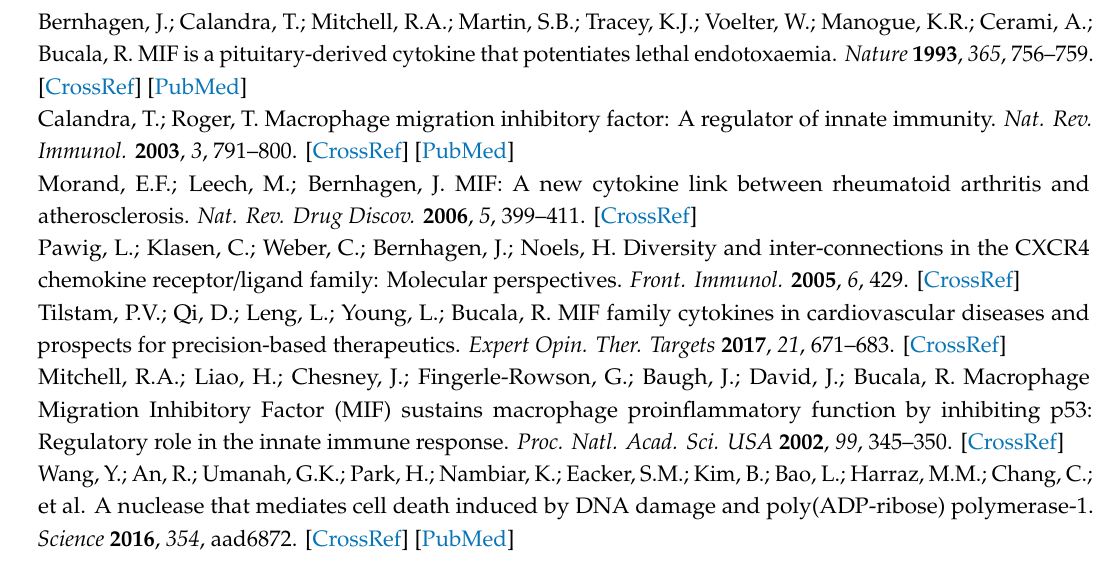
Table S1: Comprehensive list of species searched for MIF protein sequences, Table S2: Species and accession numbers of MIF sequences used as queries for the BLAST searches, Figure S1: MIF copy number as a function of taxa, environment, and lifestyle, Figure S2: Plant MIF phylogeny, Figure S3: MIF phylogeny of fungal species, Figure S4: Maximum likelihood analyses of MIF sequences from Stramenopila and Alveolata, Figure S5: Maximum likelihood phylogeny of MIF sequences from nematodes and insects. The dataset supporting the phylogenetic analyses is available in the TreeBase repository (http: // purl.org / phylo / treebase / phylows / study / TB2: S21992?x-access-code = 4a0cbb6434be939b700c0fee1c363e8d&format =